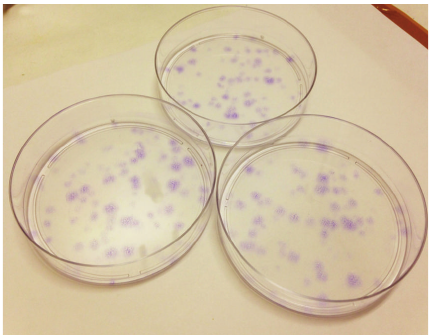
Figure 20: Colony forming unit assay. CFU assay on OSA3-CSCs line stained with Toluidine Blue.